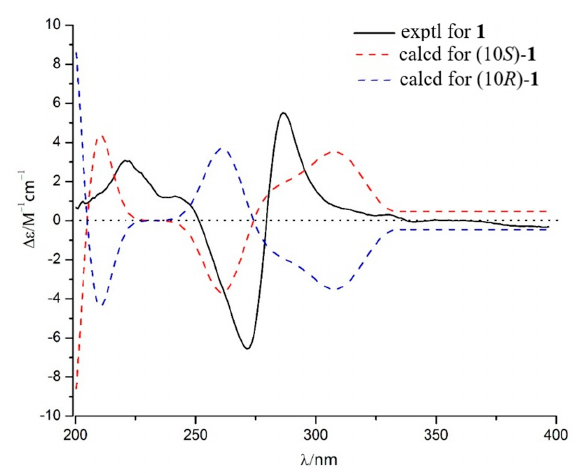
Figure 3. Calculated and experimental electronic circular dichroism (ECD) spectra of 1 . Talanaphthoquinone B ( 2 ) was isolated as a red solid with [ α ] 25 D : − 16.8 ( c 0.1, MeOH). The